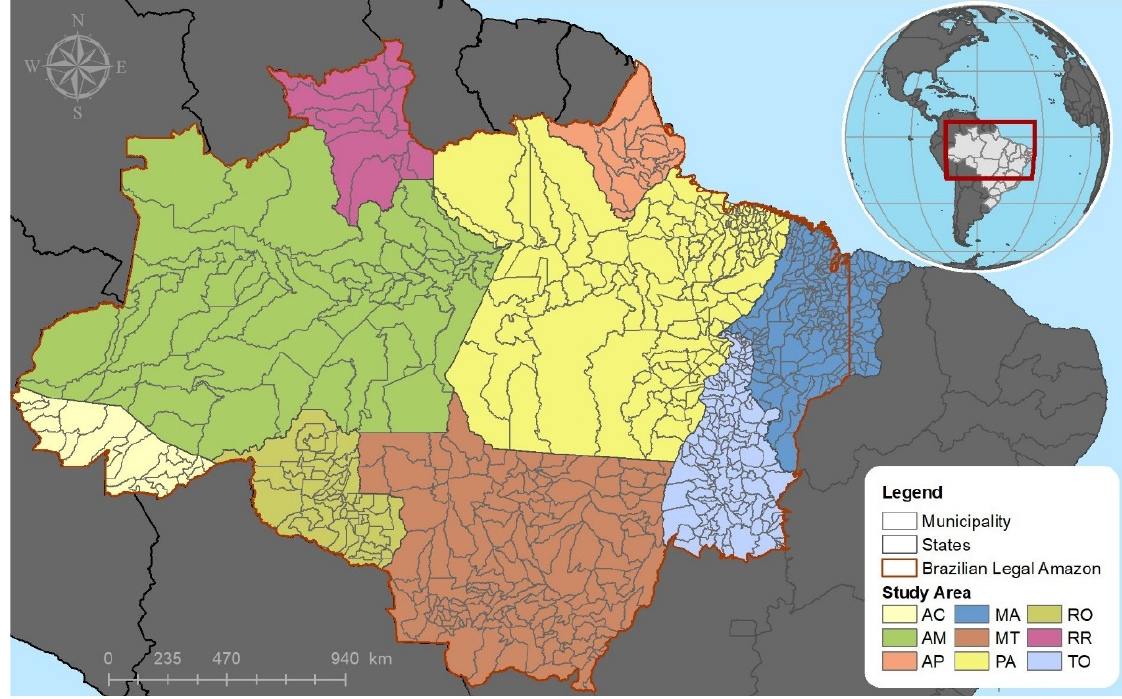
Figure 1. Municipalities within the nine states of the BLA used in this study.